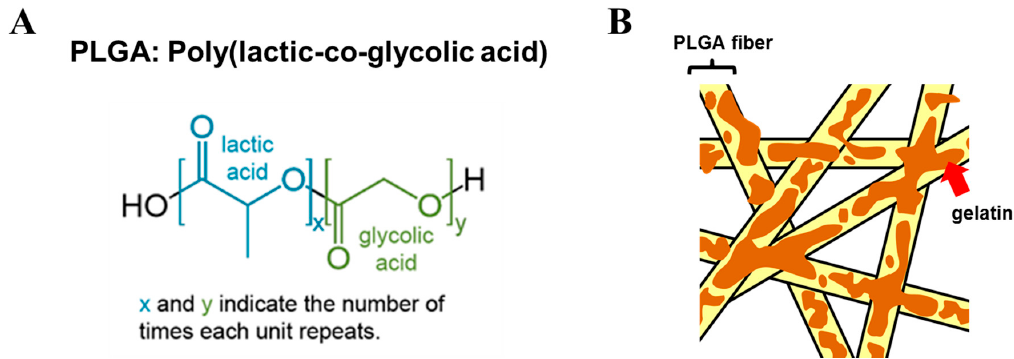
Figure 12. Chemical structure of PLGA ( A ) and cartoon ( B ) suggesting how the PLGA/gelatin mix might resemble. ( A ) Structure of PLGA. ( B ) Tight and dense nano-fibrous structure of embedded gelatin on PLGA fibers. The interaction between the two polymers is non-covalent. The uniform distribution of the gelatin allows the formation of a biodegradable MC with cell adhesion suitable surfaces.